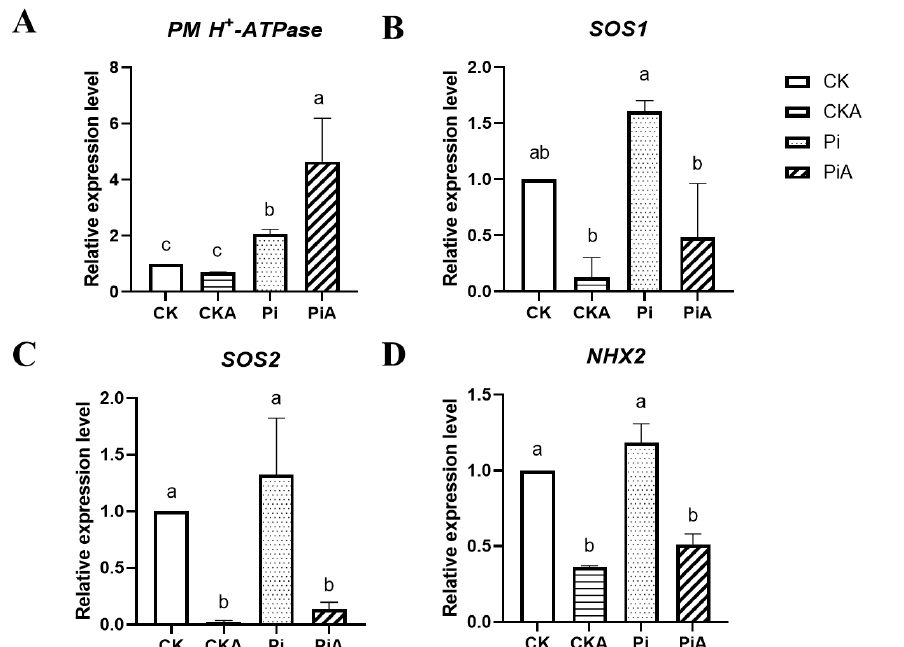
Figure 7. The relative gene expression levels of ( A ) PM H + -ATPase , ( B ) SOS1 , ( C ) SOS2 , and ( D ) NHX2 gene from P. indica -colonized (Pi) and non-colonized (CK) soybean roots under salt stress. Values represent means ± standard deviation of three replicates. Different lowercase letters above the bars indicate statistically significant differences at the 0.05 level by Duncan’s multiple-range test.